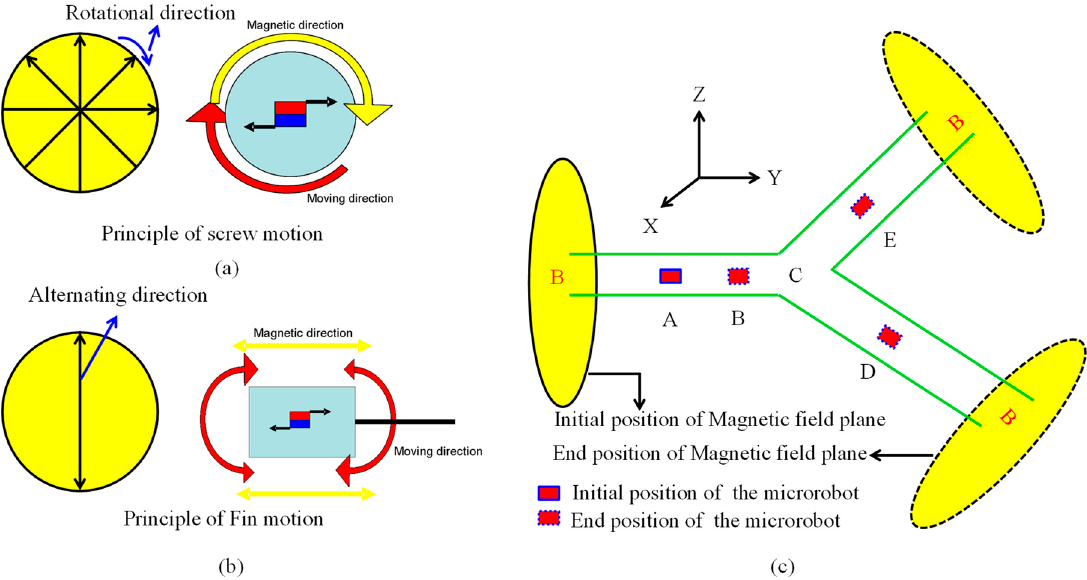
Figure 4. Movement principle of the magnetically actuated capsule microrobot with hybrid motion.